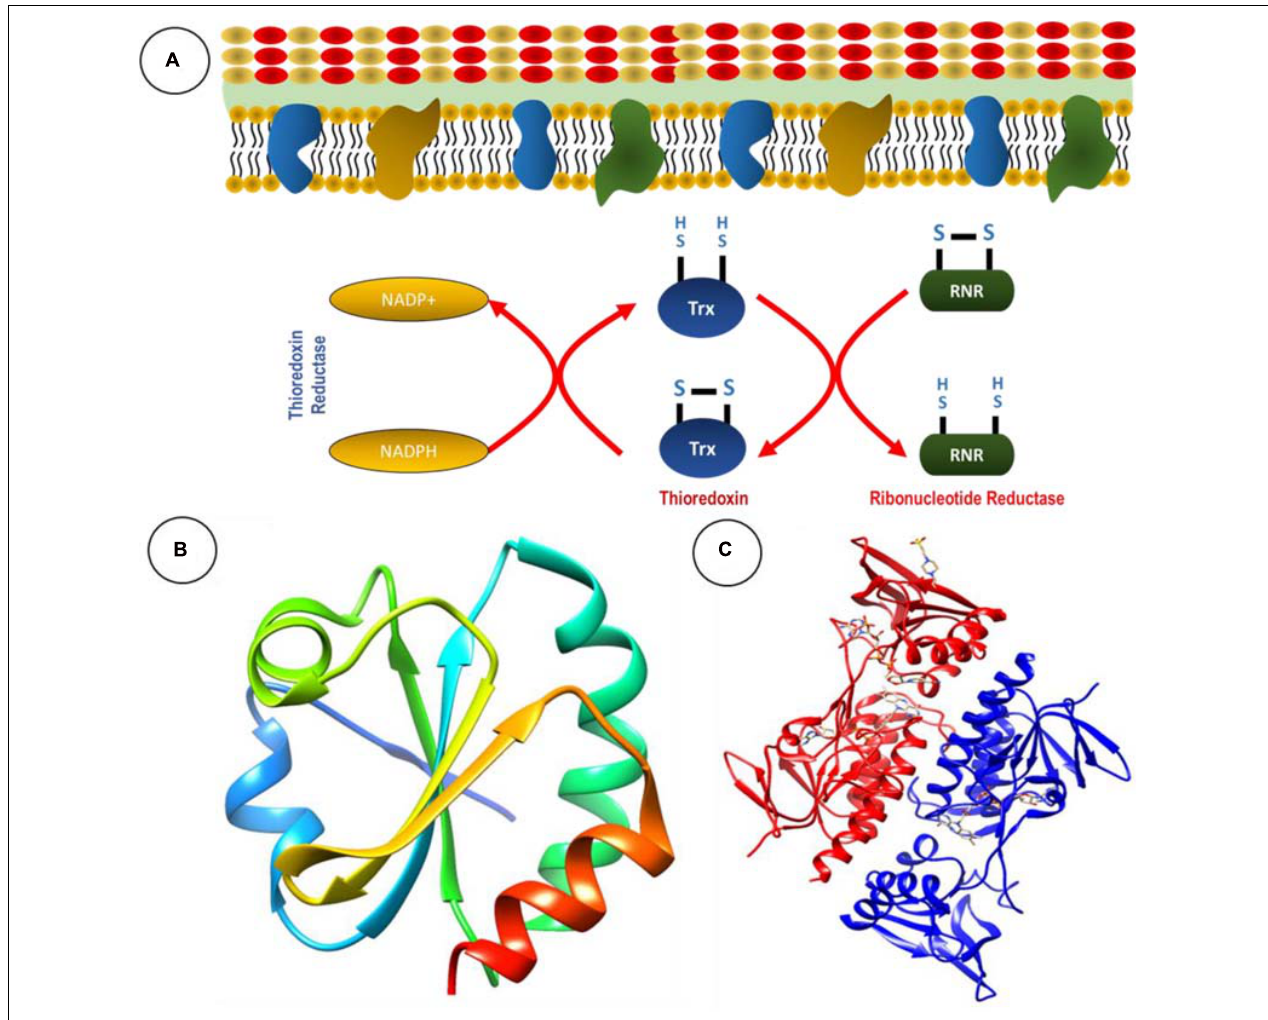
FIGURE 1 | The thioredoxin system serves as an antioxidant system. (A) Basic chemical reaction of thioredoxin system in bacteria. Ribbon structure of (B) thioredoxin and (C) thioredoxin reductase from Staphyloococcus aureus generated through UCSF Chimera 1,14 software.